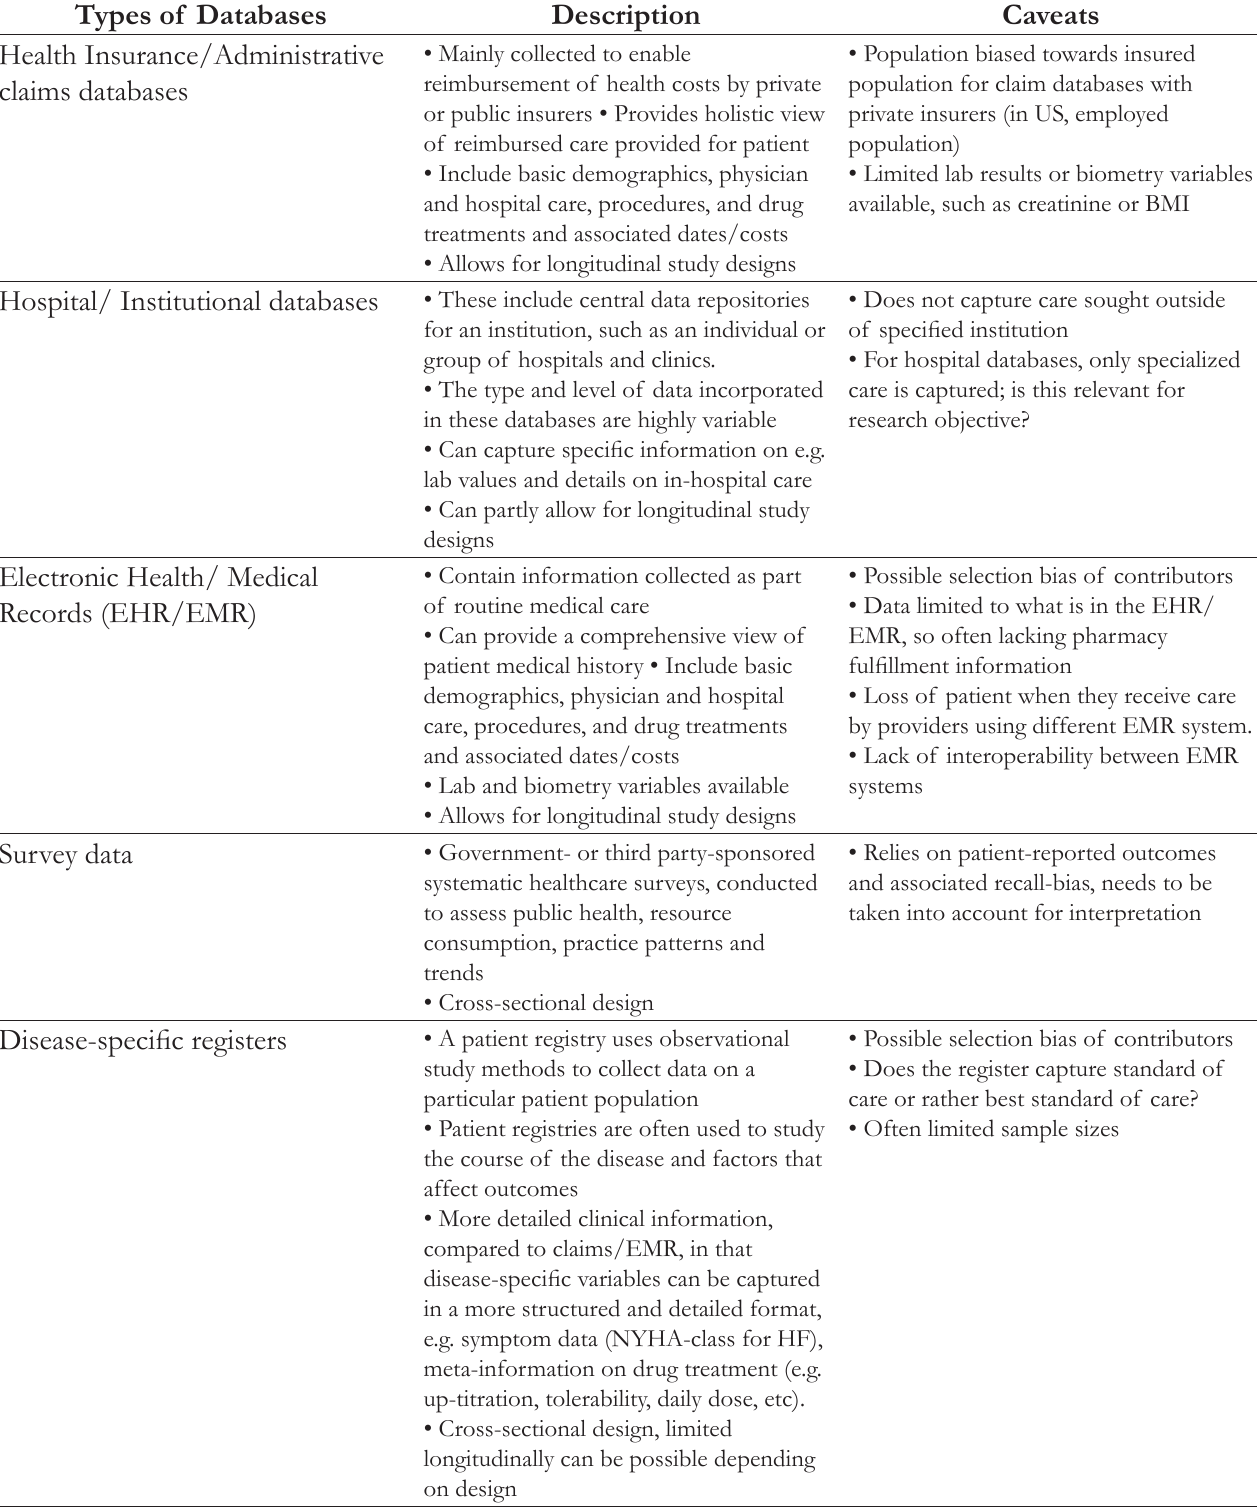
Table 1. Common Data Sources Types of